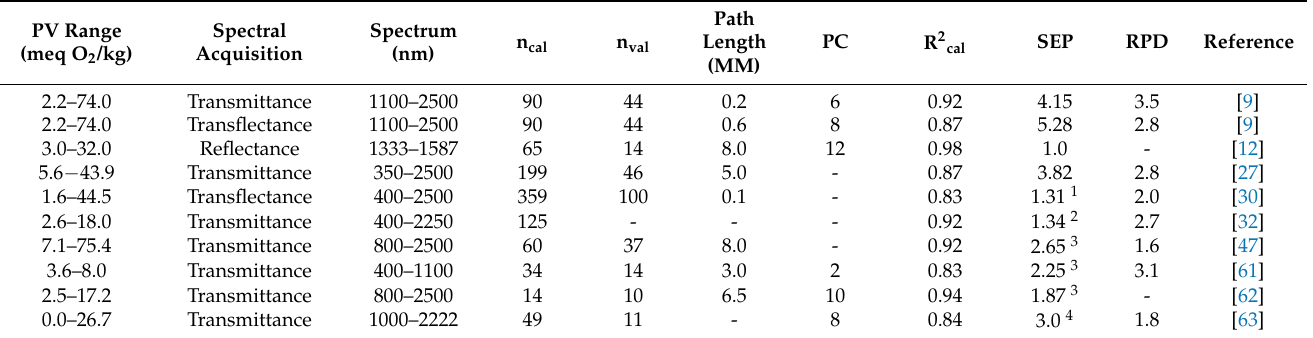
Table 4. PLS statistics obtained for peroxide value (PV) of olive oils using different PV ranges, visible/NIR spectral intervals, and optical path lengths.